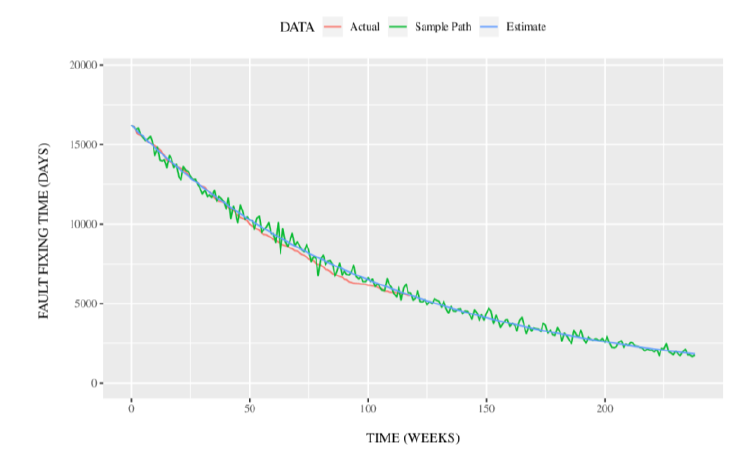
Figure 3. Remaining fault fixing time using exponential model in Eqs. (11) and (13)